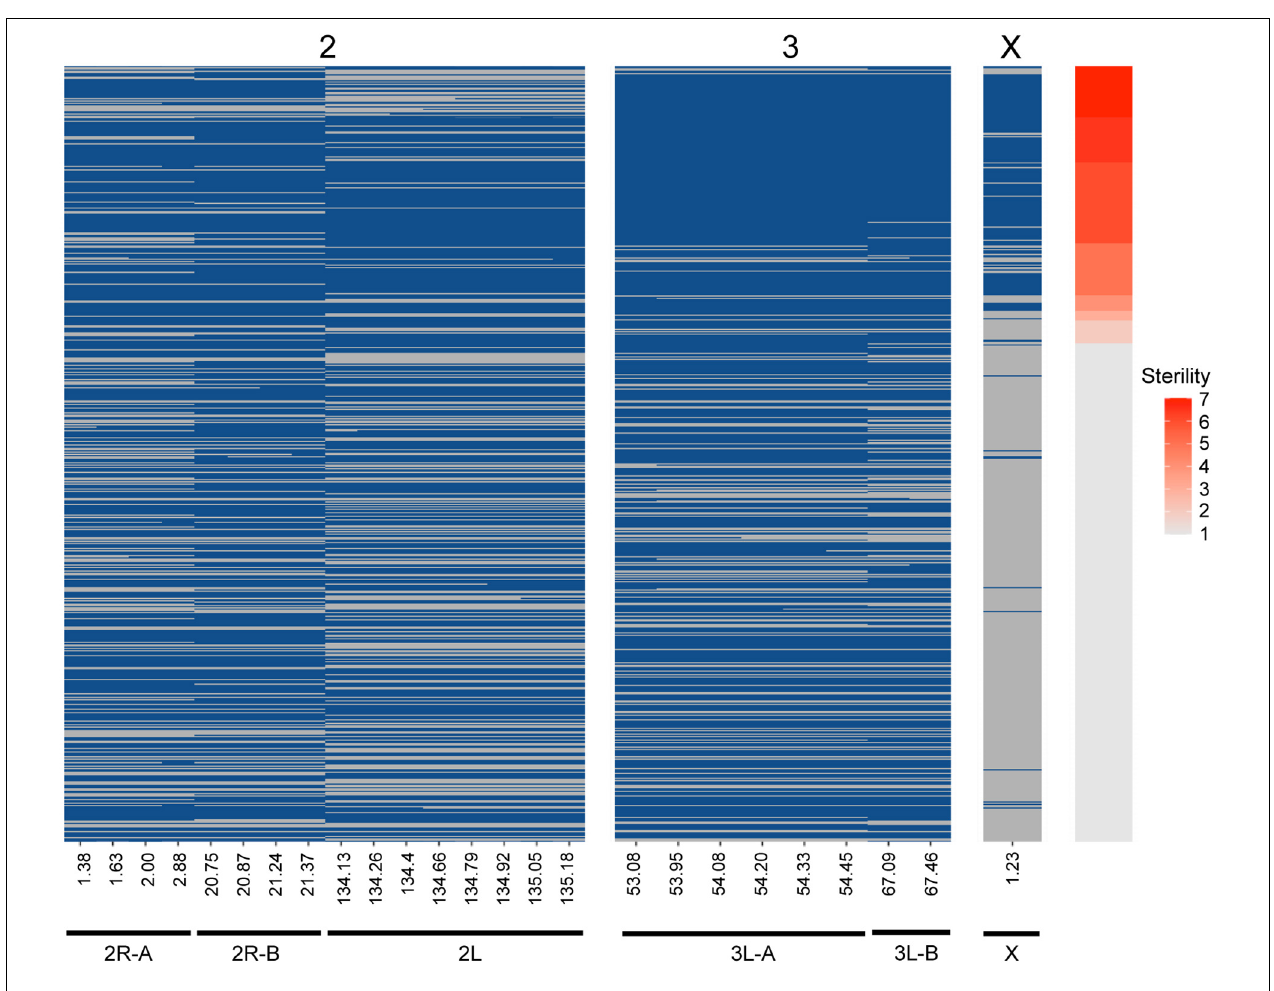
FIGURE 4 | Genotype heat map for each An. coluzzii × An. quadriannulatus backcross male hybrid ( y -axis) at the six QTL ( x -axis) identified using CIM and multiple imputation. All markers within the 1.5 LOD interval of each QTL peak ( Table 2 ) are included ( x -axis, positions in cM). Individuals are sorted on the y -axis by sterility, with the individuals with the highest sterility score (7) at the top. Blue cells indicate Aquad/Acolz heterozygosity on the autosomes, and Acolz hemizygosity on the X chromosome. Gray cells indicate Aquad/Aquad homozygosity on the autosomes, and Aquad hemizygosity on the X chromosome. TABLE 3 | Percentage of An. quadriannulatus homozygosity at hybrid male sterility autosomal QTL peaks in the full, An. quadriannulatus X chromosome, and An. coluzzii X chromosome datasets. Full dataset An. quadriannulatus X An. coluzzii